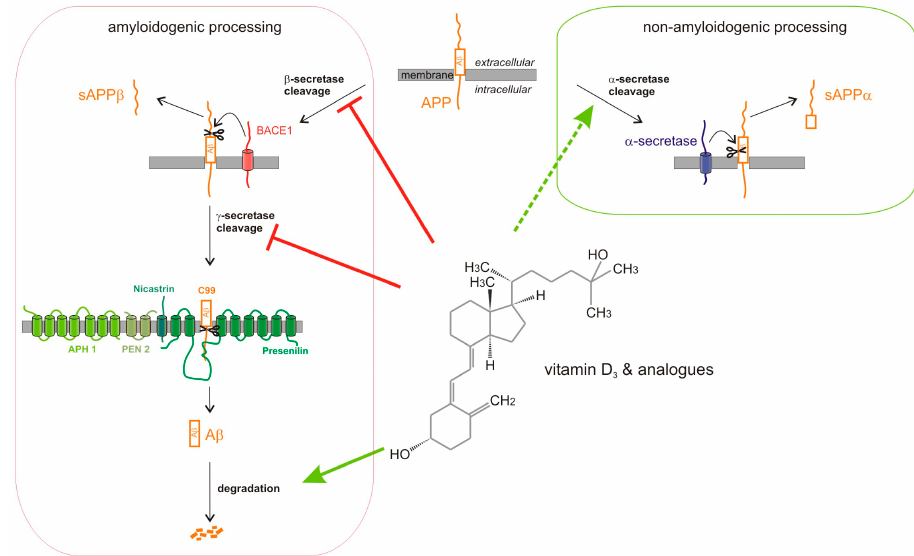
Figure 6. Model of the pleiotropic effects of vitamin D and analogues on A β -homeostasis. Vitamin D and analogues decrease amyloidogenic amyloid precursor protein (APP) processing by affecting β - and γ -secretase activity. The reduction of β -secretase activity is caused by a direct effect of vitamin D and its analogues on β -secretase activity combined with indirect effects on BACE1 gene expression and total BACE1 protein level. The γ -secretase activity is reduced by decreased gene expression of nicastrin responsible for the maturation of the heterotetrameric γ -secretase complex. A stimulation of the non-amyloidogenic α -secretase processing of APP was found for 25(OH) vitamin D 3 and the vitamin D 2 analogue paricalcitol. Total A β level in presence of vitamin D and analogues are further reduced by increased A β -degradation.